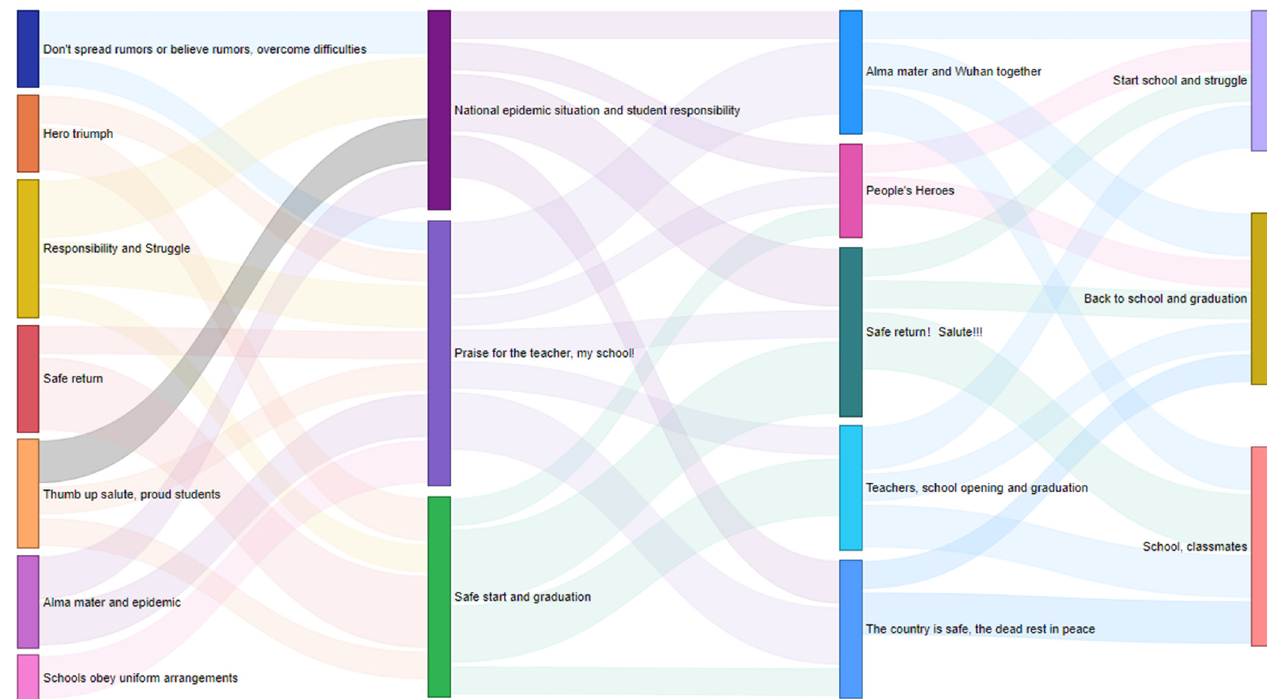
Figure 10. Topic content evolution map of negative comment.